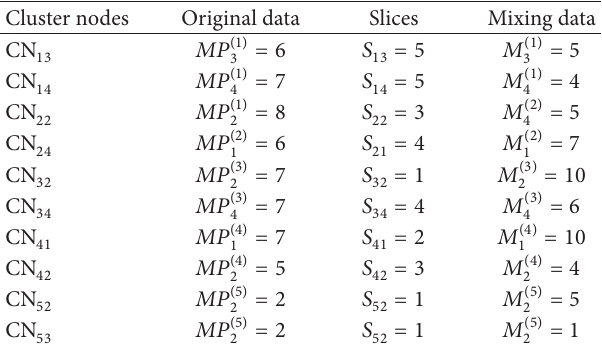
Table 4: The intercluster data aggregation.